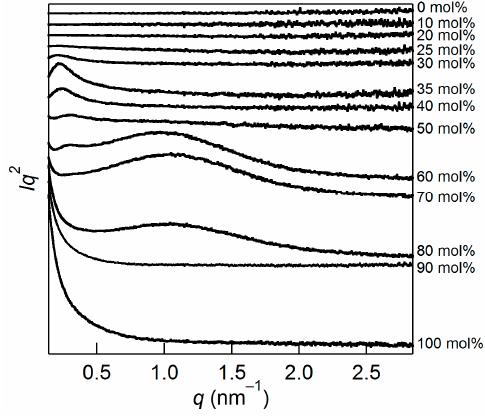
Figure 2. Small angle X-ray scattering (SAXS) patterns of the cellulose/[Emim][OAc] mixtures in the Kratky plot.